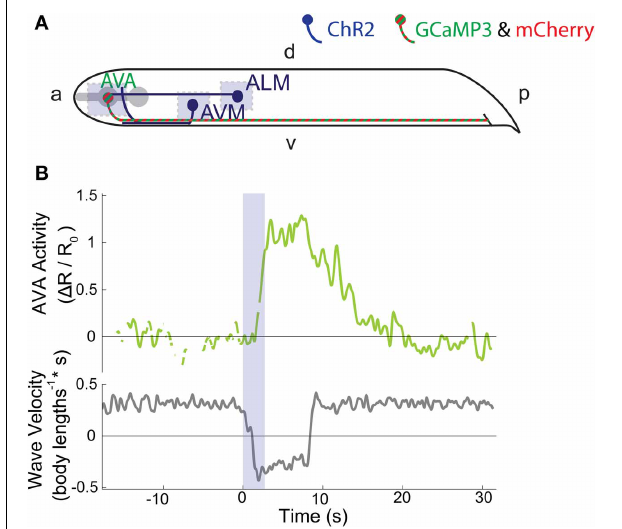
FIGURE 2 | (A) ChR2 is expressed in six soft-touch mechanosensory neurons, including ALM and AVM (dark blue). Calcium indicator GCaMP3 and fluorescent reference mCherry are expressed in command interneuron AVA (striped green and red). Light blue shaded regions indicate areas of illumination. “a” is anterior, “p” is posterior, “d” is dorsal, and “v” is ventral. (B) Intracellular calcium dynamics of AVA (green line) are measured before during and after optogenetic stimulation of the ALM touch neuron (2.7s stimulation, blue shaded region). The velocity of the worms body bending waves is shown in